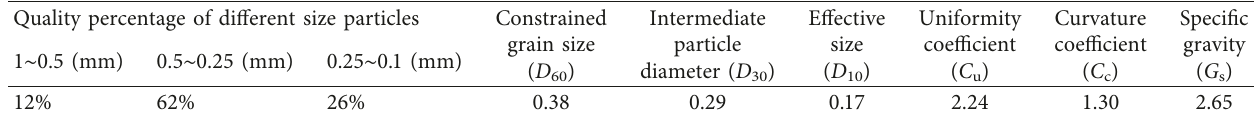
Table 1: Physical properties of sand.